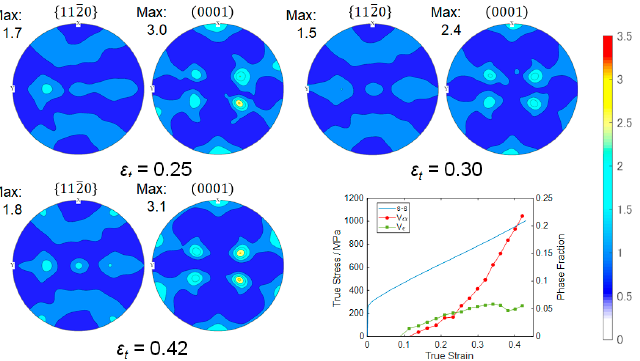
Figure 2. Analyzed 1120 and {0001} pole figures of the ε martensite at various true strains ( ε t ). The contour step was 0.5. The increase in the volume fractions of the α ’ (V α ) and ε (V ε ) martensite phases with increasing strain is also shown.